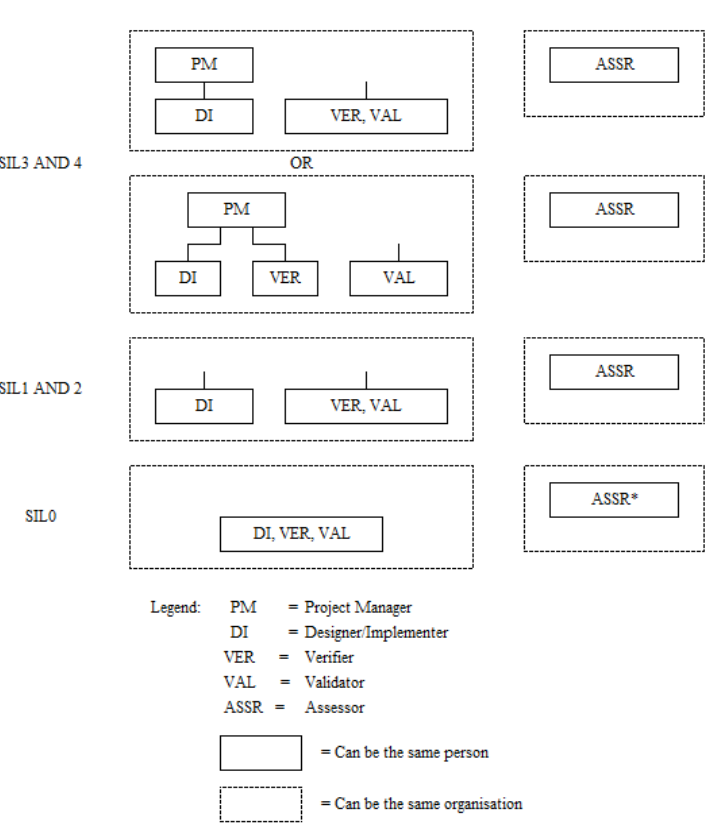
Figure 2. Arrangements for independence (EN 50129)